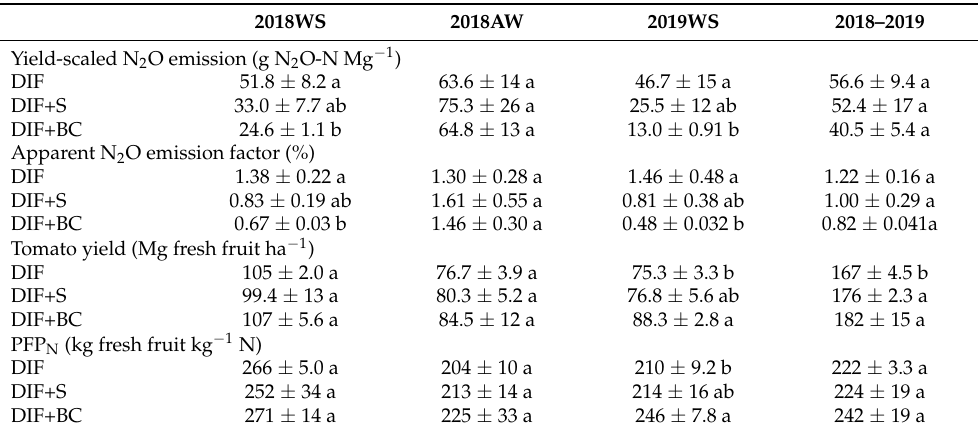
Table 3. Seasonal and annual values of yield-scaled N 2 O emissions, apparent N 2 O emission factor, tomato yield and partial factor productivity of applied nitrogen fertilizer (PFP N ) during winter–